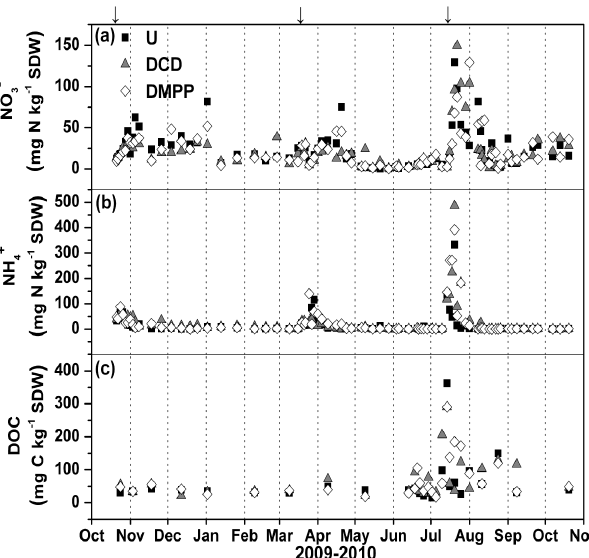
Fig. 3. Temporal courses of soil (a) nitrate (NO − ) and (c) dissolved organic carbon (DOC) contents for the (NH + 4 urea (U), urea + DCD (DCD) and urea + DMPP (DMPP) treat- ments. SDW: soil dry weight. The downward ( ↓ ) arrows indicate the fertilization